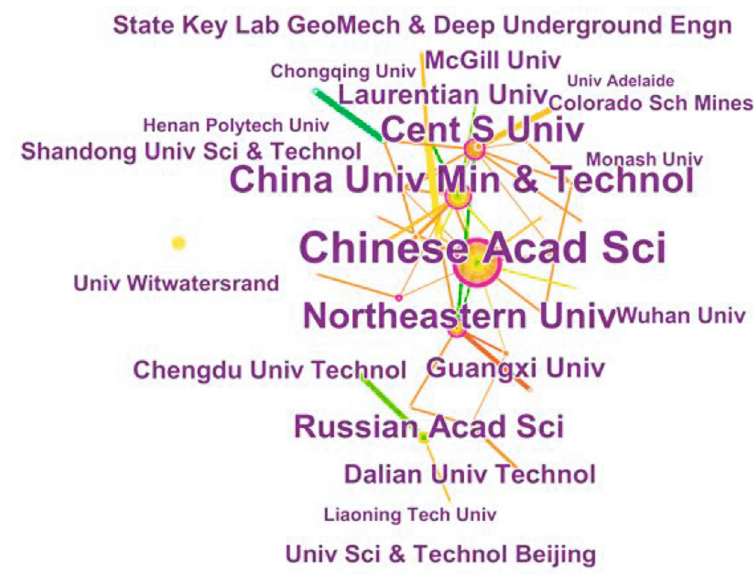
Figure 6: Institution cooperation